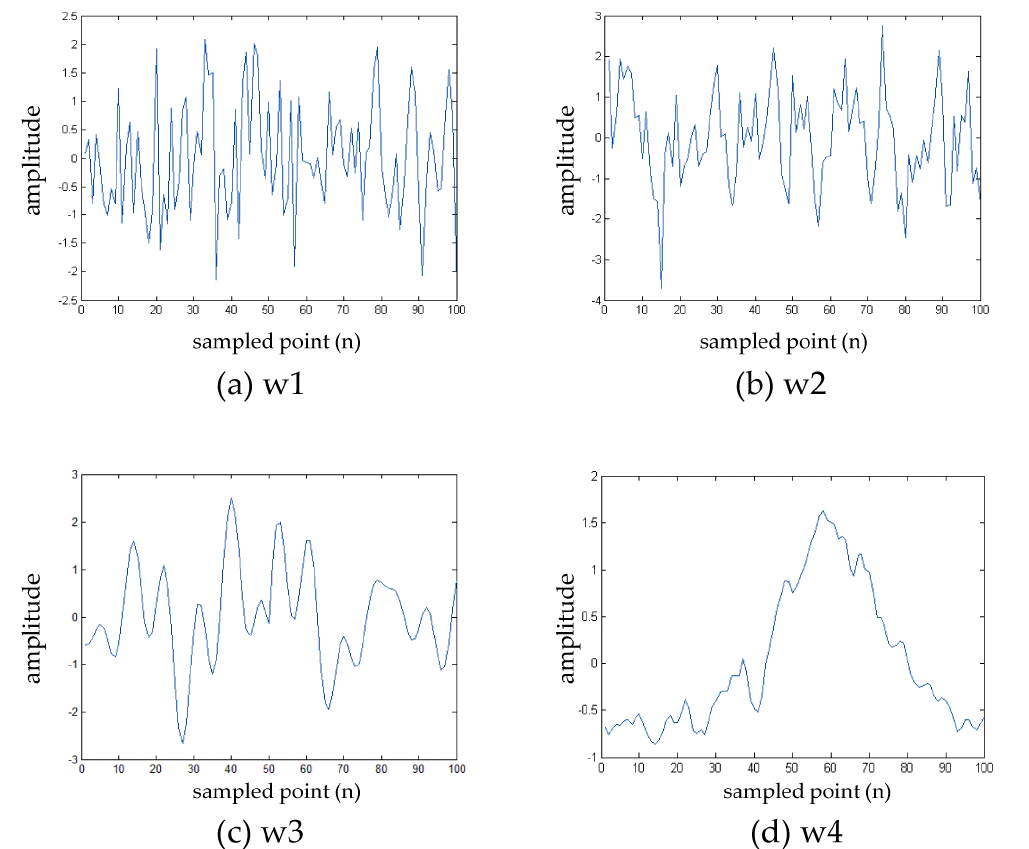
Figure 2. Signal waveforms for simulations. ( a ) White random signal; ( b ) colored random signal; ( c ) deterministic signal; and ( d ) EEG signal.